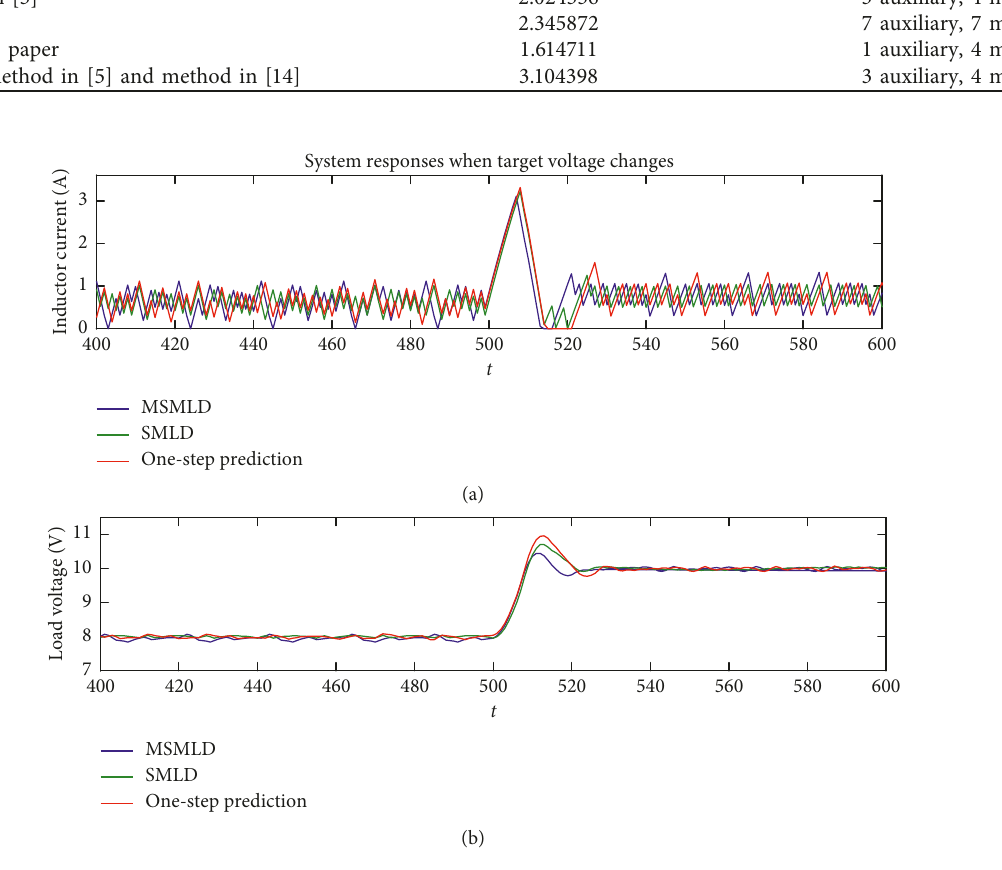
Figure 8: Inductor current and output voltage responses of three methods when target voltage changes.